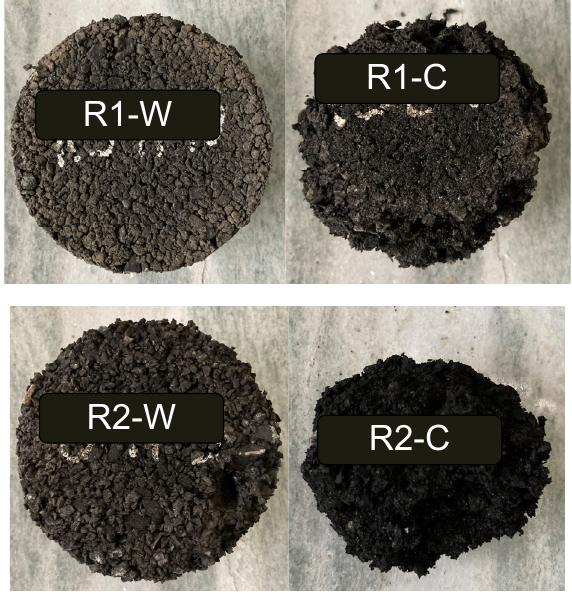
Figure 10. Aspect of the samples after the Cantabro test at the control time (no F–T). R1-C behaviour is hard to explain; the loss at t = 0 is 60%; this value increases to approximately 90% in cycles 1 and 5, and it goes back to 61% after 10 cycles. However, with respect to R2-C, with the same binder, an increase in the amount of loss with cycles is evident. The loss values of R2-C samples at t = 0, 5, and 10 cycles are higher than those of R1-C